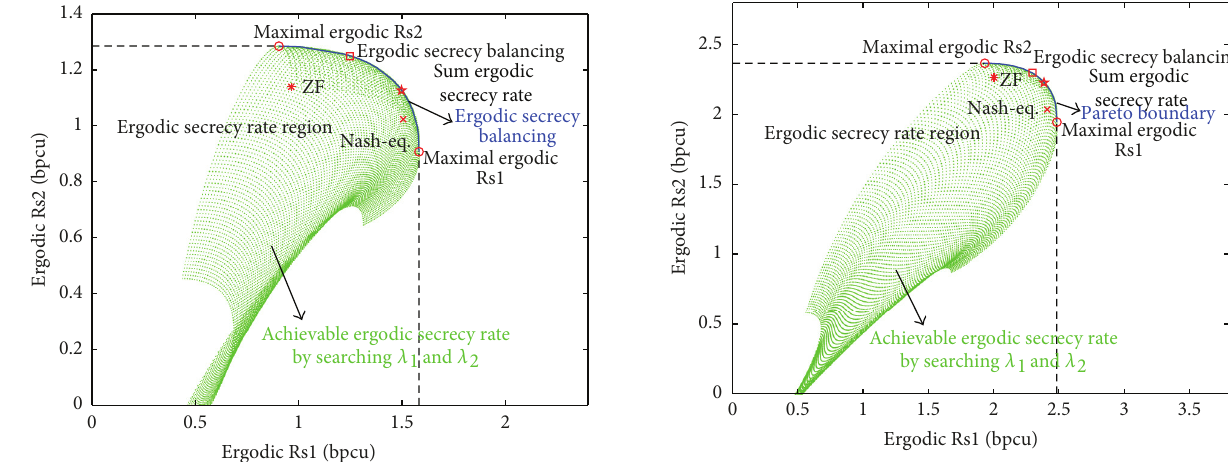
Figure 3: Ergodic secrecy rate region with 5dB SNR for a random channel realization.